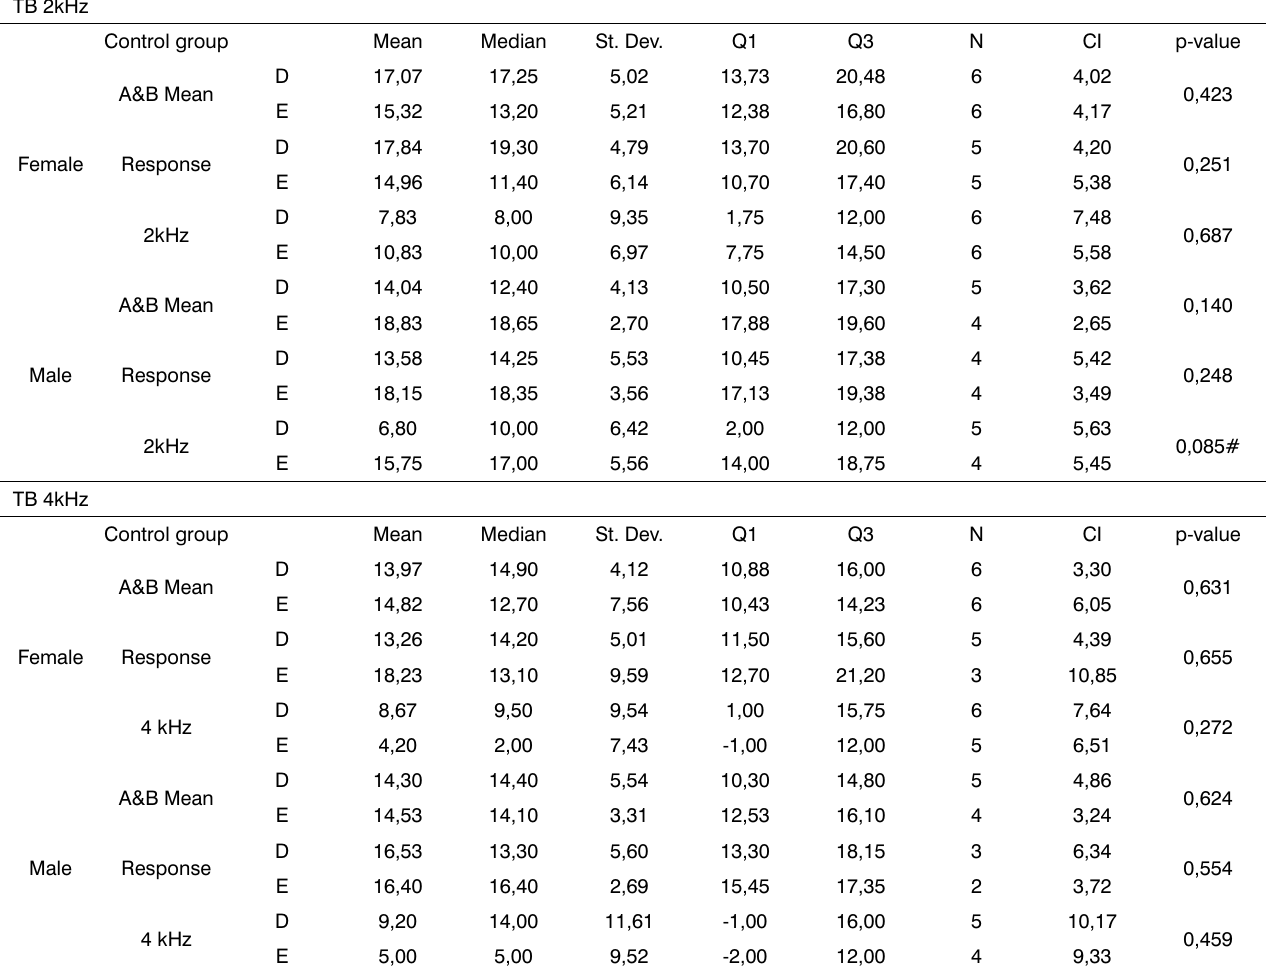
Table 3. Response magnitude (dB), descriptive analysis and comparison (p-value) between RE and LE for case group, on TB 2 kHz and TB 4